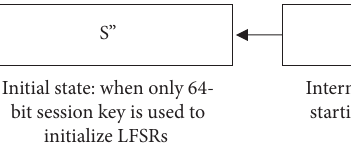
Figure 2: Relation between S , S ′ , and S ″